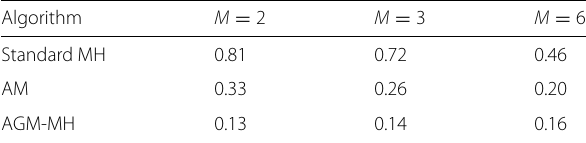
Table 7 Normalized auto-correlation (at lag one) for the univariate Gaussian target in Section 6.1